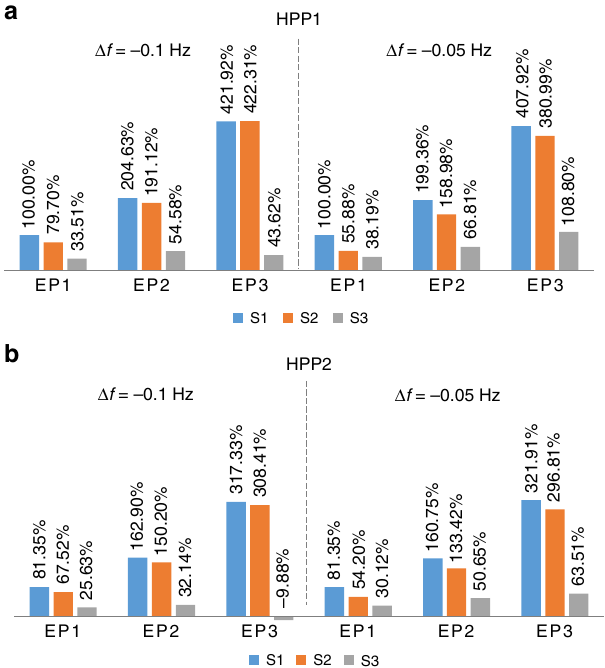
Fig. 5 Strength payments based on the strength obtained from the − 0.1 Hz frequency step change and a − 0.05 Hz frequency step change. For each frequency change case, the relative values are normalized with the respect to the strength under Ep1 and S1 for HPP 1. a For HPP 1; b For HPP